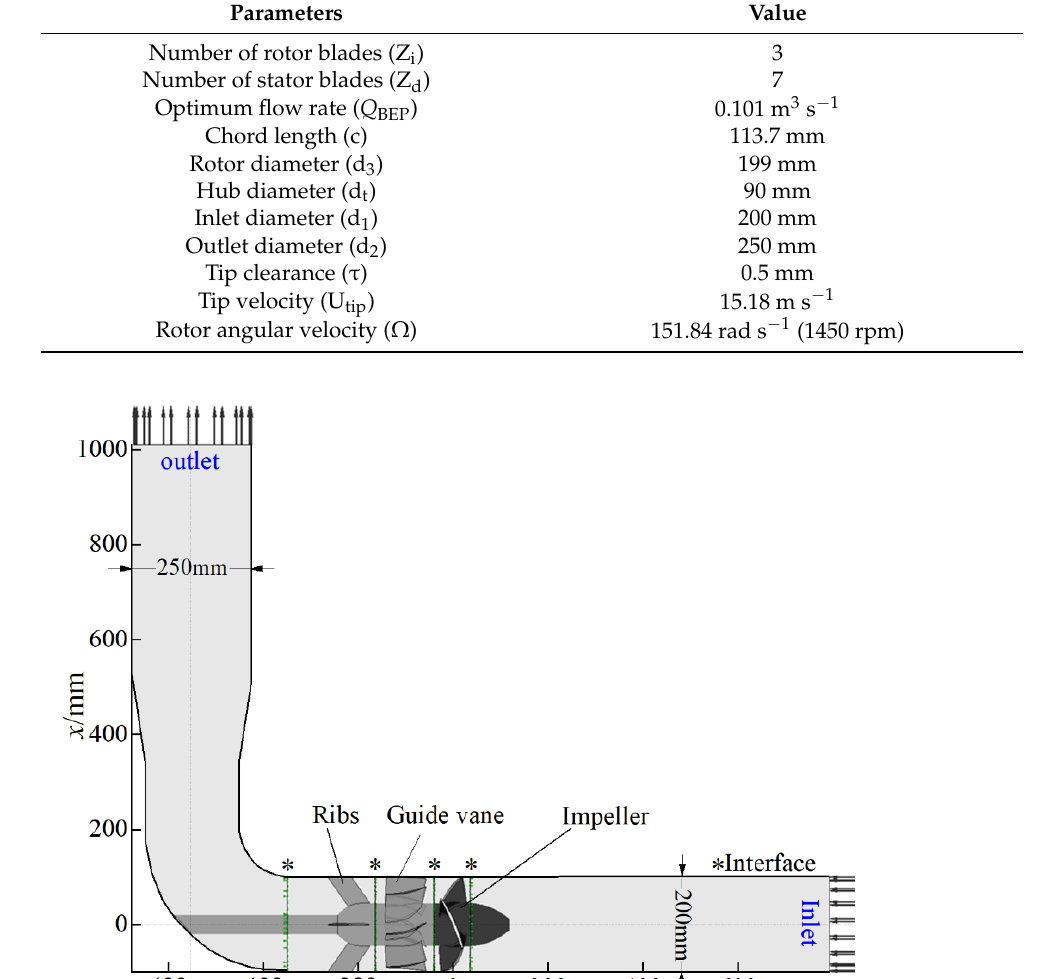
Table 1. Pump geometry and reference data.